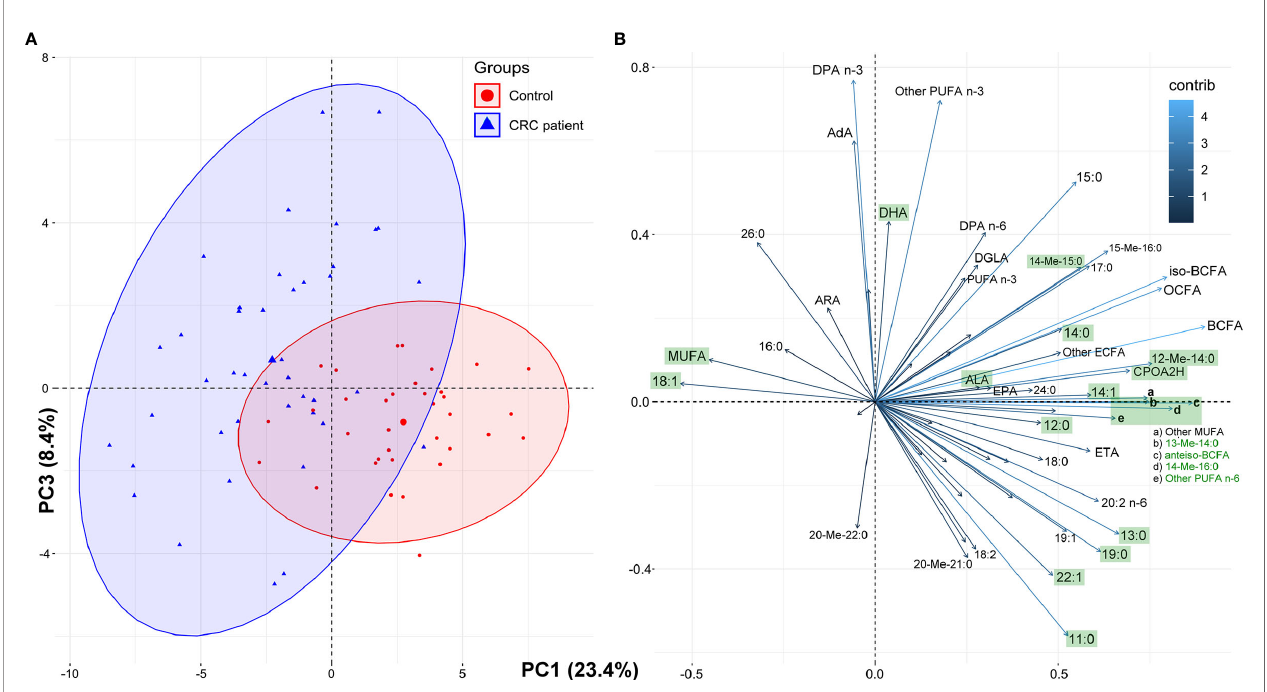
FIGURE 2 | The results of principal component analysis (PCA) based on the whole fatty acids pro fi le in serum of the study subjects: score plots of cases (A) and variables (B) . Fatty acids marked green displayed statistically signi fi cant differences in their average serum concentrations between the control group and CRC patients (paired t-test, p < 0.05; see Table 1 for details and abbreviations); some minor variables were not shown to keep the clarity of